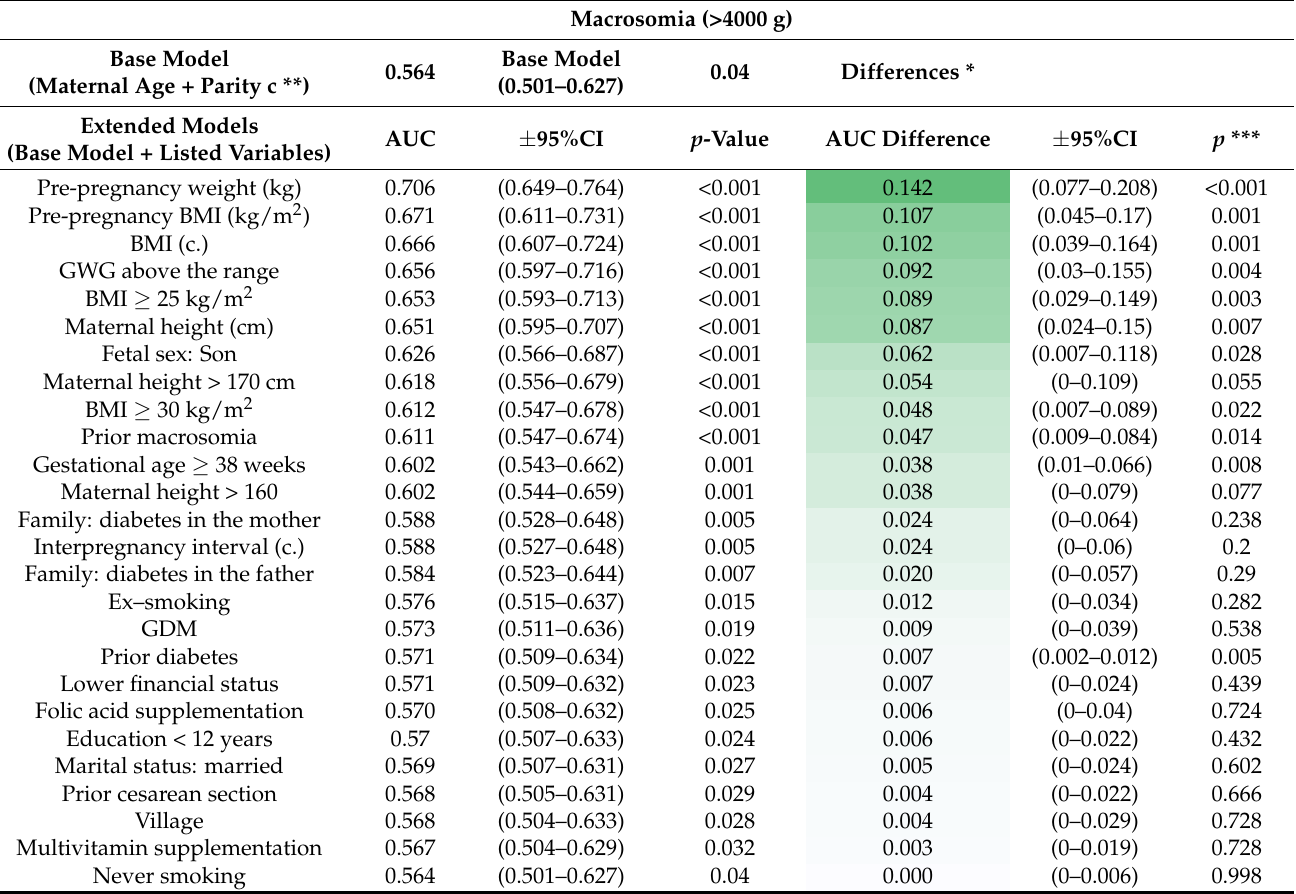
Table 3. AUC values in the extended multivariate models for the probability of